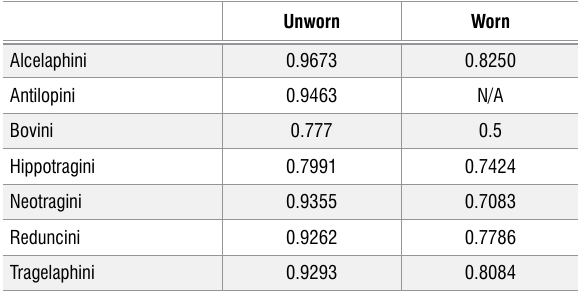
Balanced accuracy of the classification of teeth by Tribe